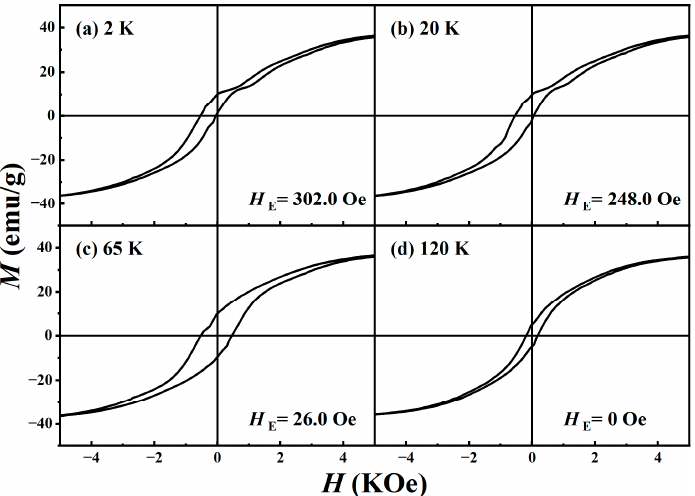
Figure 6. Magnetization hysteresis loops measured at ( a ) T = 2 K, ( b ) T = 20 K, ( c ) T = 65 K, and ( d ) T = 120 K.